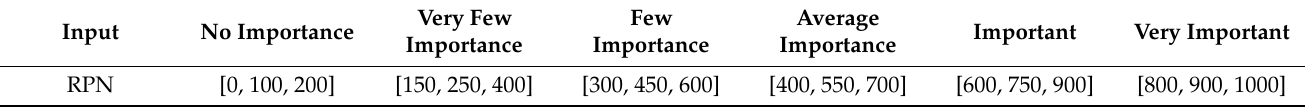
Table 4. Linguistic variables and membership functions for